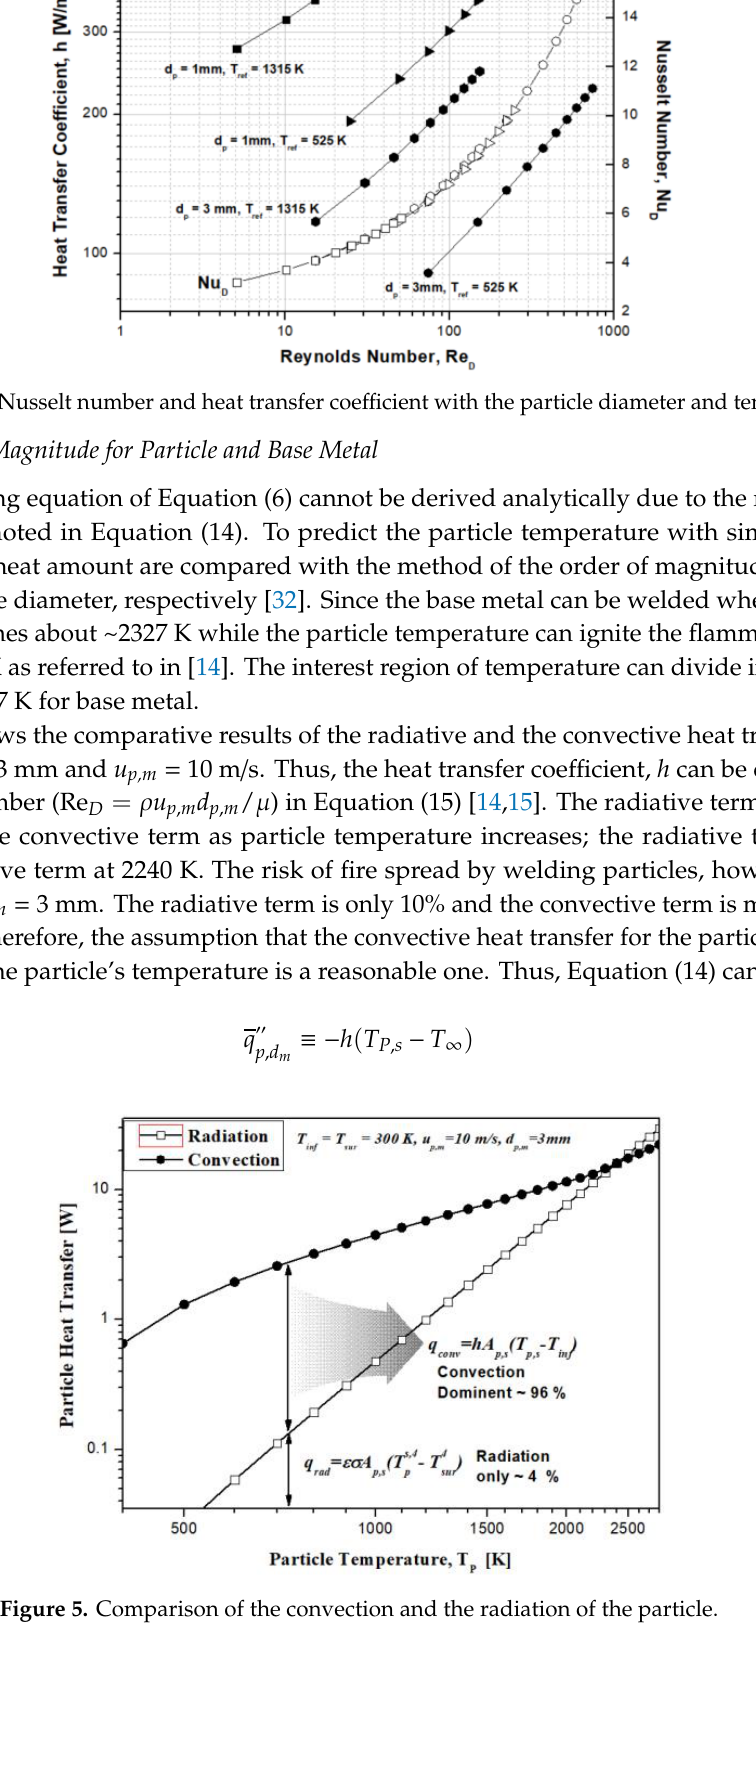
Figure 6. Comparison of the convection and the radiation of the base metal. 2.6. Model Equation for Surface Temperature of the Particles From the analysis of the heat transfer for the particle and base metal, Equation (6) for the energy balance in the SMAW can be rearranged as Equation (19) using with Equations (3), (17) and (18) for the steady state condition.